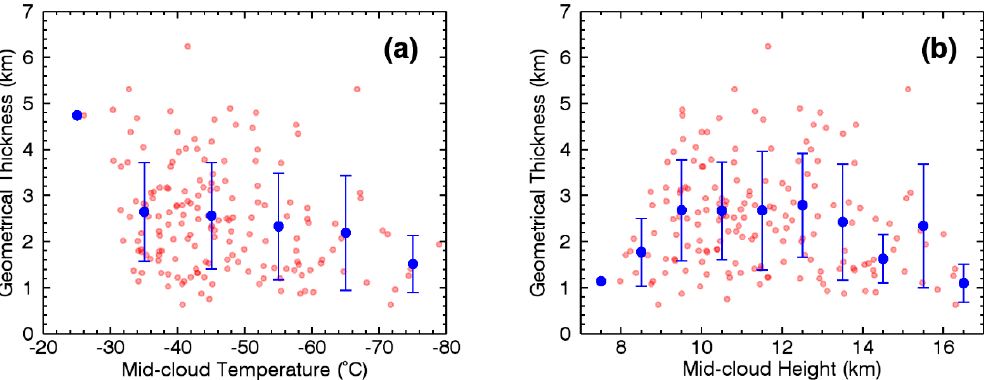
Figure 5. Scatterplots (red dots) showing the relationships between cirrus geometrical thickness, and ( a ) mid-cloud temperature and ( b ) mid-cloud height based on a total of 168 cirrus cloud events from one-year lidar observations at Wuhan. Blue dots and vertical bars are the associated mean values and standard deviation grouped in every 10 °C and 1 km respectively. Note that the cirrus geometrical thickness tends to decrease with the lowering mid-cloud temperature.